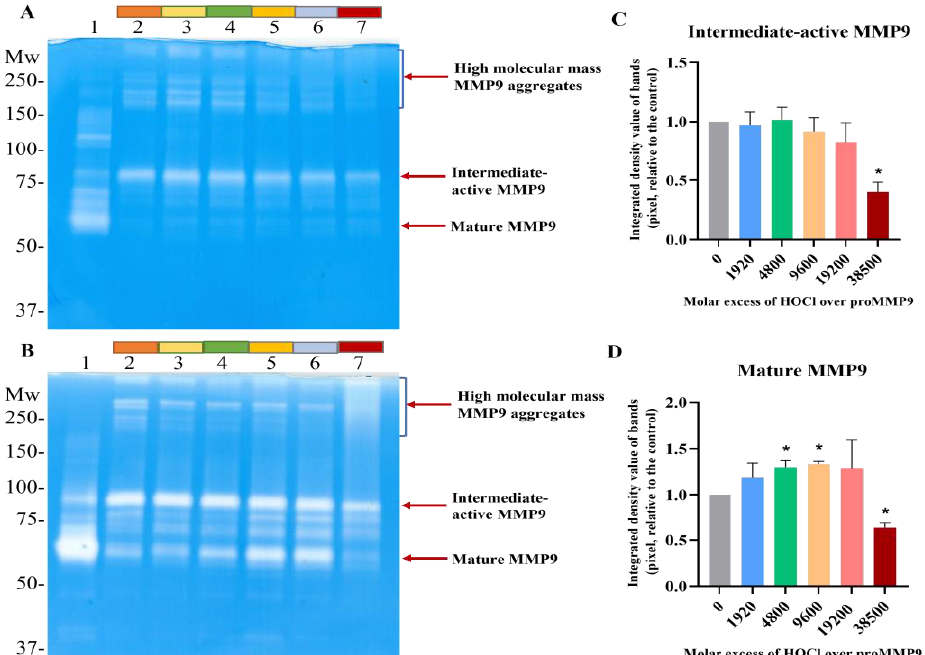
Figure 2. Effect of HOCl on proMMP9 activation detected by gel zymography. ( A , B ) 52 nM proMMP9 was exposed to either 1 mM APMA (positive control: Panels A and B, Lane 1) or increasing molar excesses of reagent HOCl (0, 1920, 4800, 9600, 19,200 and 38,500; Lanes 2–7) for 2 h (Panel A) or 24 h (Panel B) at 37 °C. The control and oxidized samples were then subjected to gel zymography, as described in the Section 2. The absence of blue staining (i.e., white bands) indicates the presence of active MMP9 isoforms, as this indicates the degradation of the gelatin in the gel and, therefore, a decrease in protein staining. ( C , D ) Image analysis of the band densities from the 24 h activation zymogram gel shown in Panel B. Band intensities of an active intermediate form of MMP9 (see Panel B) are shown in Panel C, and for the mature-form MMP9 in Panel D. Data are presented as means ± SDs from three independent experiments, and gel images are representative examples. Statistical analysis was performed using one-way ANOVA with Dunnett’s multiple comparisons test, with significance against the nontreated group at the p < 0.05 level indicated by *. The positions of the molecular-mass markers are indicated on the left of each gel image.